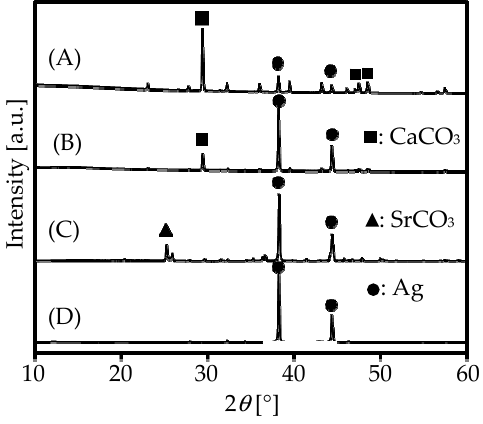
Figure 2. XRD patterns of ( A ) Ag(5.6)-Na(1) / CaCO 3 , ( B ) Ag(56)-Na(1) / CaCO 3 , ( C ) Ag(56)-Na(1) / SrCO 3 , and ( D ) Ag(56)-Na(1) / MgCO